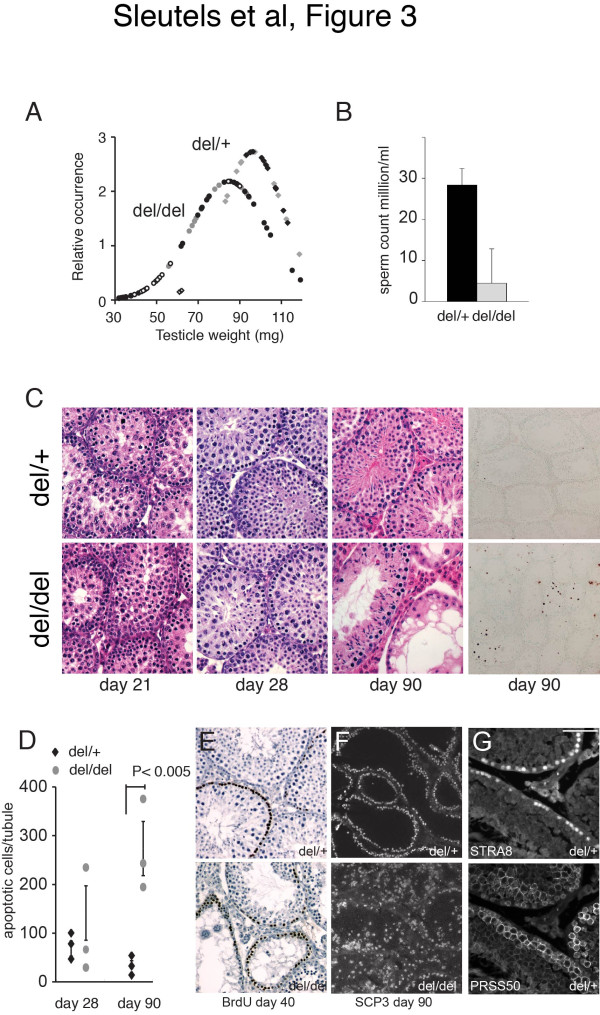
CTCFL is important for spermatogenesis. A Testicular weight distribution. The testicular weight of Ctcfl heterozygous (Ctcfldel/+; diamonds) and homozygous (Ctcfldel/del; circles) mice was measured and plotted as a normalized probability distribution (i.e., the surface under the curve represents a total probability of 1). Testes of knockout mice are significantly smaller (p < 0.0005, t-test). White symbols represent infertile males, black symbols are fertile males, and grey symbols correspond to males not tested for fertility. B Ctcfl mutant mice display reduced fertility. Epididymal sperm count from Ctcfl heterozygous (Ctcfldel/+; black bar) and homozygous (Ctcfldel/del; grey bar) mice. Standard deviation is plotted (p = 0.0002, n = 4). C Testis histology. In the left three panels a timed series of HE-stained testicle sections is shown (postnatal day 21, 28, 90), while in the right hand panel an apoptosis assay (TUNEL staining) of testicle sections at day 90 is shown. Note that in CTCFL-deficient testes some seminiferous tubules appear normal, whereas others (which can be adjacent to the normal ones) have lost most of their meiotic and post-meiotic germ cells, leaving only mitotic spermatogonia (that stain positive for BrdU incorporation, see panel E) and Sertoli cells. Yet other tubules contain disorganized spermatocytes, and some of them even elongated sperm. Thus, there is no absolute block in differentiation or progression of germ cell development, but the incomplete penetrance of the infertility phenotype is however directly linked to the testicle weight (panel A) and to the degenerative level of the seminiferous tubules. D Apoptosis plot. Number of TUNEL-positive apoptotic cells per 100 seminiferous tubules counted at day 28 and day 90. Standard deviation of three animals per genotype and time point is indicated. E DNA synthesis marked by a 1-h pulse of BrdU in day 40 testicles reveals that mitotic spermatogonia are still present in degenerated tubules. Counterstaining with hematoxylin. F SCP3 staining in spermatocytes of day 90 testicles as a marker for tubule organization. G PRSS50 co-localizes only partially with STRA8. Immunofluorescence staining with a STRA8 antibody (top panel) or PRSS50 antibody (bottom panel) of adult testicle sections shows that PRSS50 and STRA8 expression overlaps only partially. Scale bars are 50 μm.